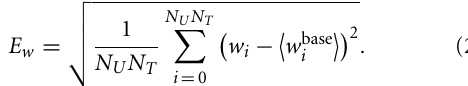
FIGURE 8 | Performance with threshold readout. As in Figure 5 the running average of the reward ¯ R is plotted averaged over 20 runs. The lower plots show the difference to the baseline trace in Figure 5A . (A) Performance traces for continuous and 8bit weights. In gray reward R for every trial in a single run with continuous weights is shown. (B) Performance traces for 4bit resolution with deterministic and probabilistic